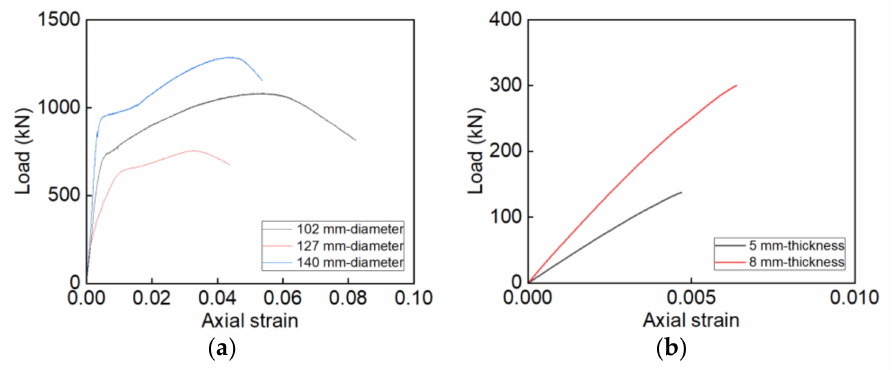
Figure 8. The load-axial strain curves. ( a ) Steel tubes; ( b ) GFRP tubes.